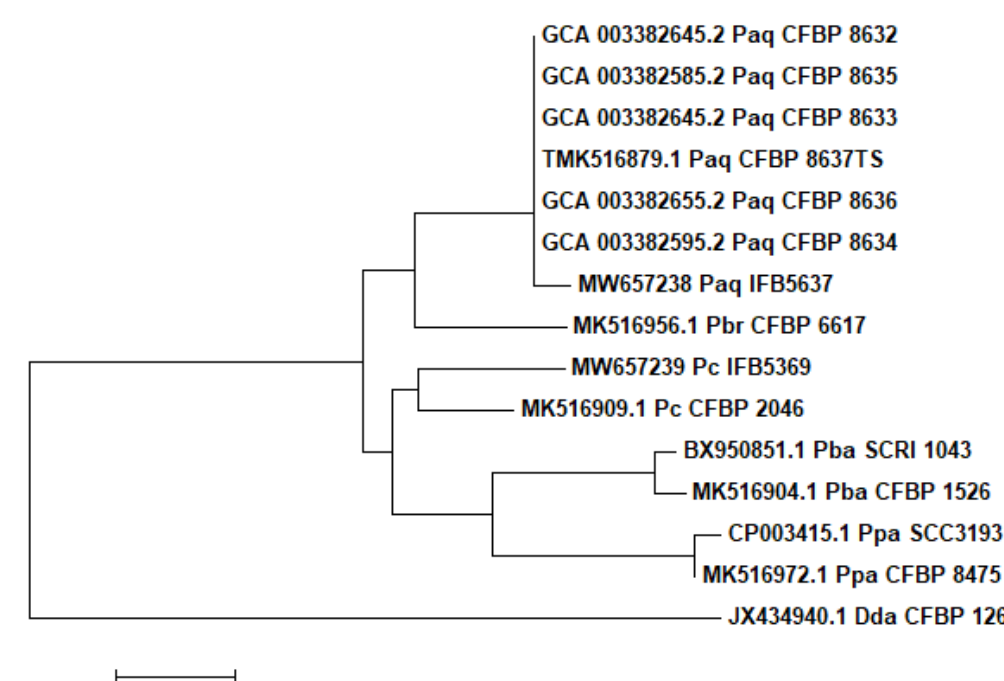
Figure 1. Phylogenetic analysis based on 535 bp fragment of dnaX gene. P. aquaticum IFB5637 isolated in Poland was juxtaposed to the Pectobacteriaceae reference strains. The sequences of the utilized strains: P. aquaticum (Paq CFBP 8632, Paq CFBP 8635, Paq CFBP 8633, Paq CFBP 8637 T , Paq CFBP 8636, Paq CFBP 8634, P. brasiliense (Pbr CFBP 6617), P. carotovorum (Pc CFBP 2046), P. atrosepticum (Pba SCRI 1043, Pba CFBP 1526), P. parmentieri (Ppa SCC3193, Ppa CFBP 8475), and D. dadantii (Dda CFBP 1269) were downloaded from the GenBank database (07.2020). The tree was generated with a neighbor-joining algorithm with the Jukes–Cantor nucleotide distance measure in the MEGA X software package. Bootstrap was set on the level of 1000 replicates.